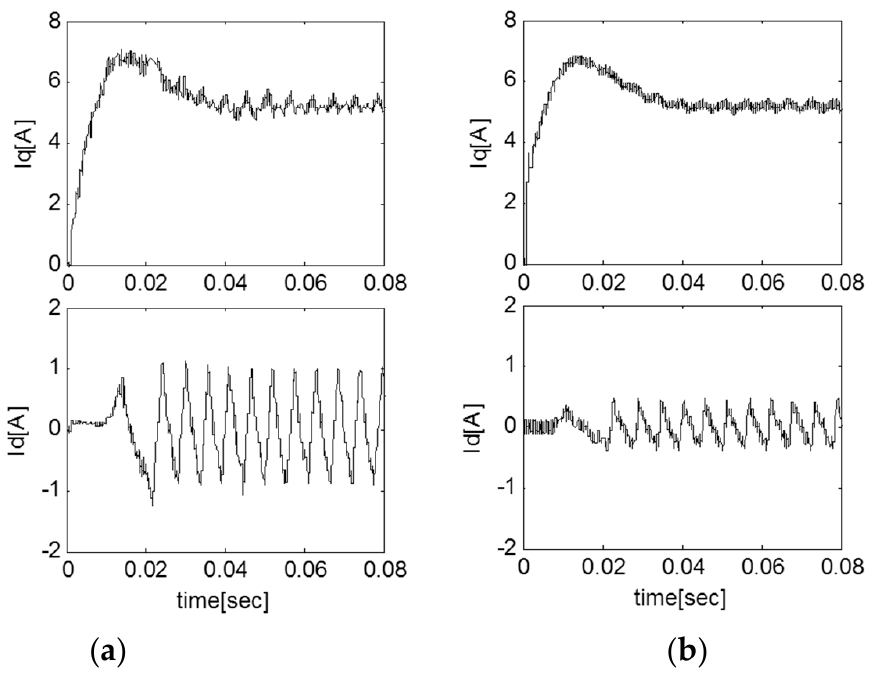
Figure 11. d- and q-axis current: ( a ) using the LPF, ( b ) using the proposed PLPF with K = 1/8.